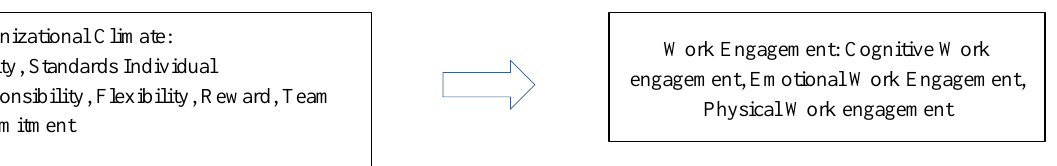
Organizational Climate: Clarity, Standards